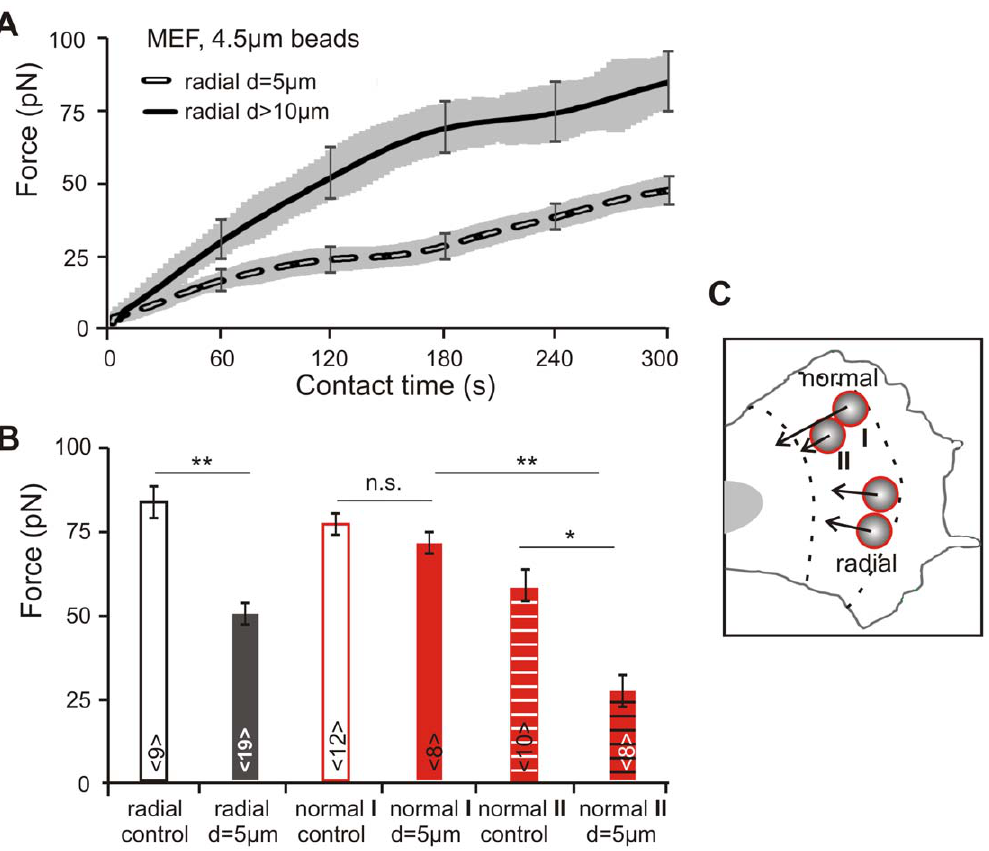
Figure 4. Influence of bead distance on force development. A) Pairs of 4.5 m m beads were positioned in a radial orientation with a center-to- center spacing of 5 or 10 m m. The averaged force-time curves show a force development similar to single beads for distances of more than 10 m m between adjacent beads (mean 6 s.e.m marked in gray and only exemplified for selected time points). With bead spacing of 5 m m, reinforcement of each neighboring adhesion site was reduced to 60%. B and C) Two bead orientations with bead spacing of 5 or 10 m m were considered: radial and normal with respect to the leading edge, respectively. Cellular traction forces applied to the normal oriented anterior bead I were significantly enhanced compared to forces acting on the posterior bead II. Control measurements were performed separately for the locations of bead I and II: in control I the anterior bead was positioned in an identical distance to the tip of leading edge as bead I, and the second bead was displaced by 10 m m toward the nucleus. For control II, the posterior bead was placed in the same distance to the leading edge tip as bead II, and the paired bead was displaced by 10 m m toward the leading edge. This procedure was necessary, as traction forces at adhesion sites decrease with increasing distance to the leading edge (N=5, n=8–19